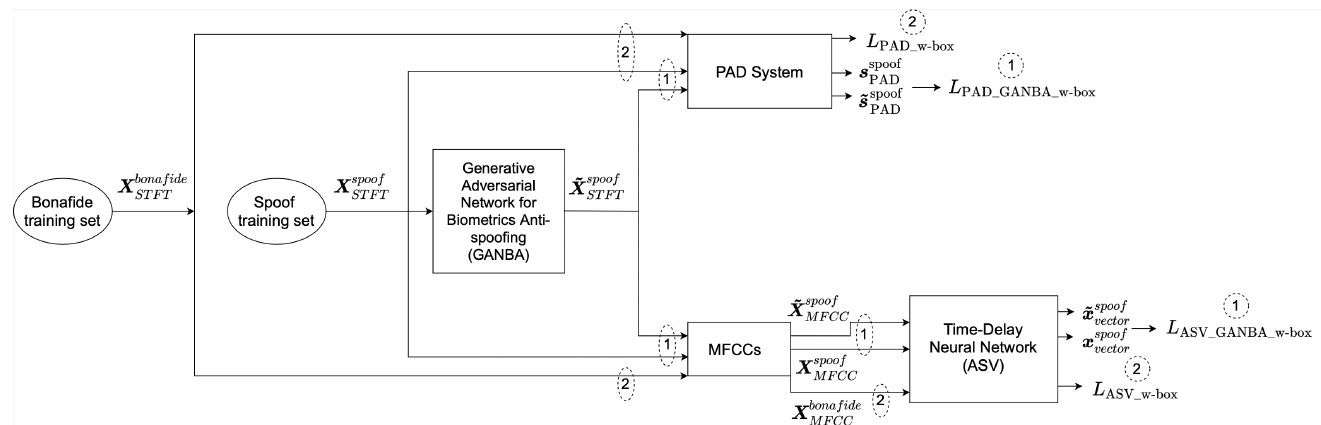
Figure 2. Generative adversarial network for biometric anti-spoofing (GANBA) framework for white-box scenarios. Step 1: generator-only training (ASV and PAD parameters frozen, with encircled outputs corresponding to Equations (7) and (8), respectively). Step 2: discriminator (ASV + PAD) training (encircled outputs corresponding to classical cross-entropy loss